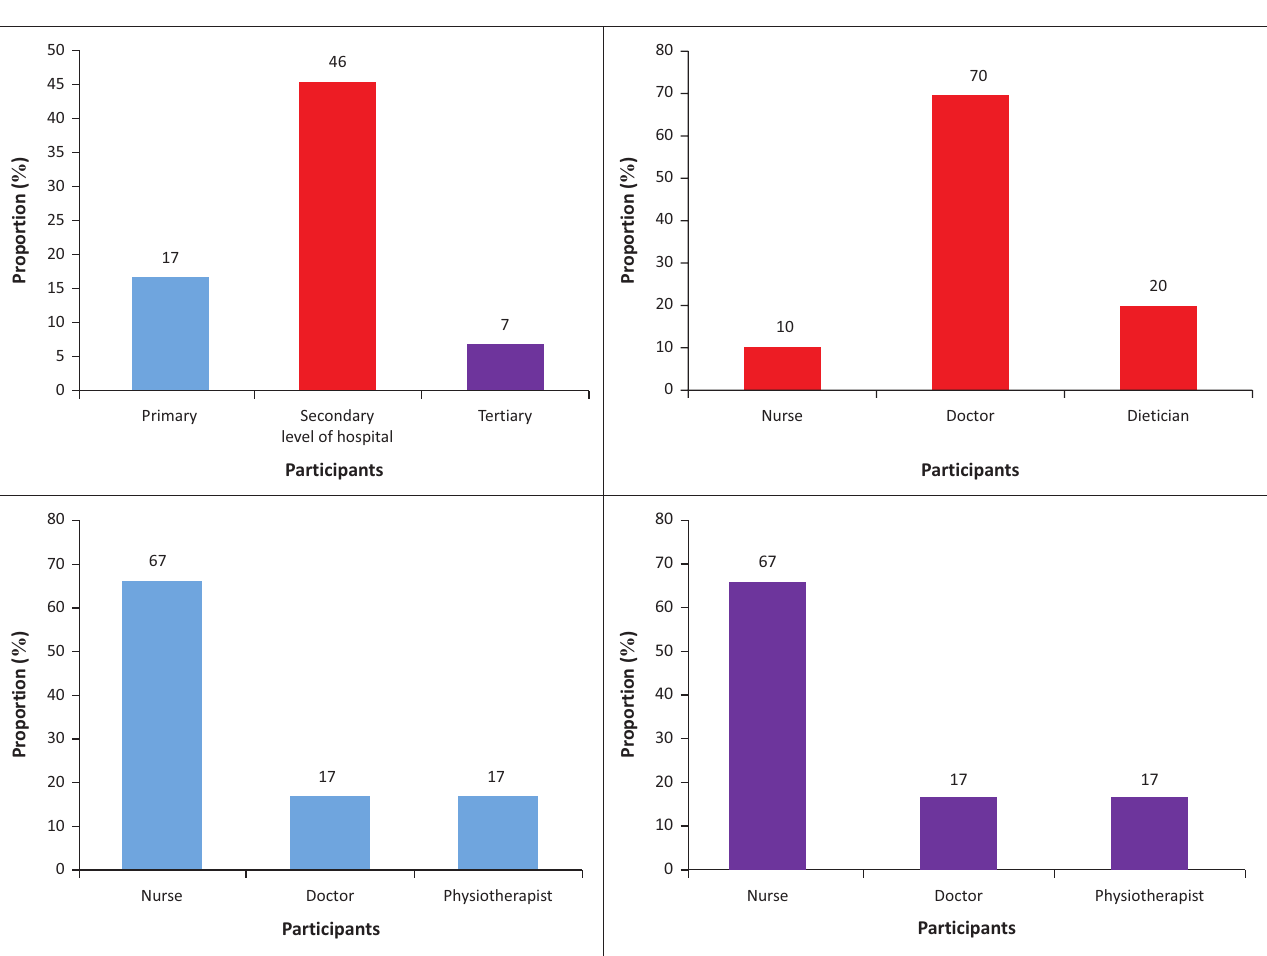
FIGURE 2: Proportion of participants reporting lack of access to stroke management protocol or